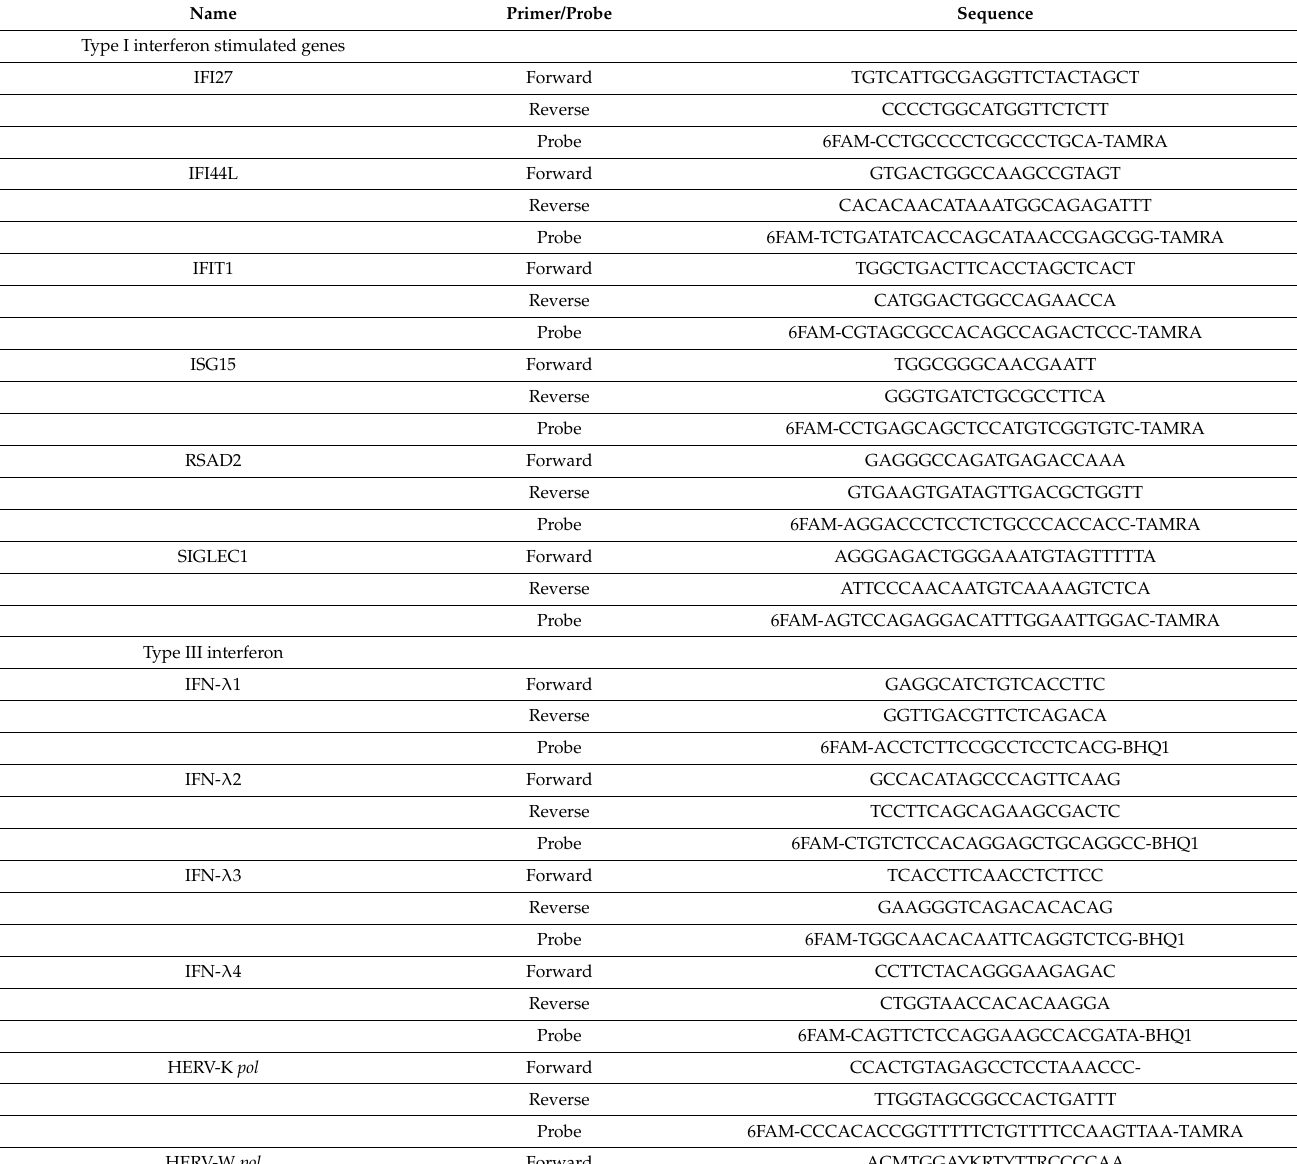
Table 1. Primers and probes used to assess the transcription levels of type I interferon stimulated genes, type III interferon genes, pol genes of HERV-K, -W, and –H, env genes of syncytin 1 and syncytin 2, TRIM28, and